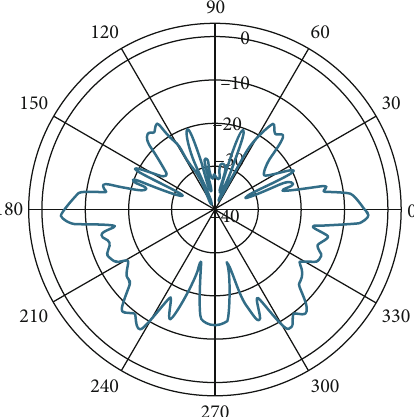
Figure 13: RCS simulation result of blue1. This radial image is called a radar picture with the radial lines representing angles and the circle representing the value of RCS in dB. The forward RCS of the fi ghter is the smallest, while the lateral and backward RCS are larger.